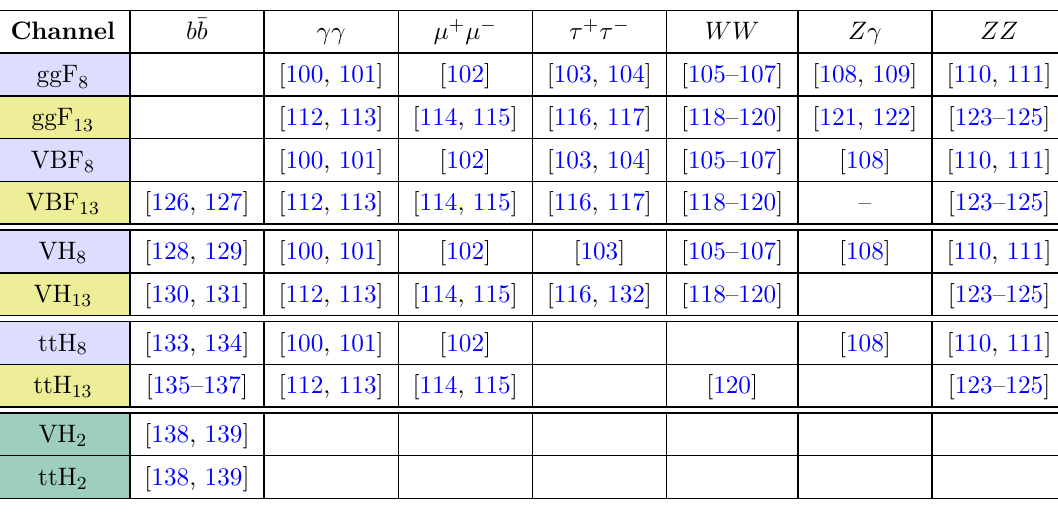
Table 4. Higgs signal strengths input used in the fit, for different production and decay channels, √ at energies of s = 7 , 8 TeV (ATLAS and CMS, Run I), √ and s = 2 TeV (D0 and CDF collaborations).